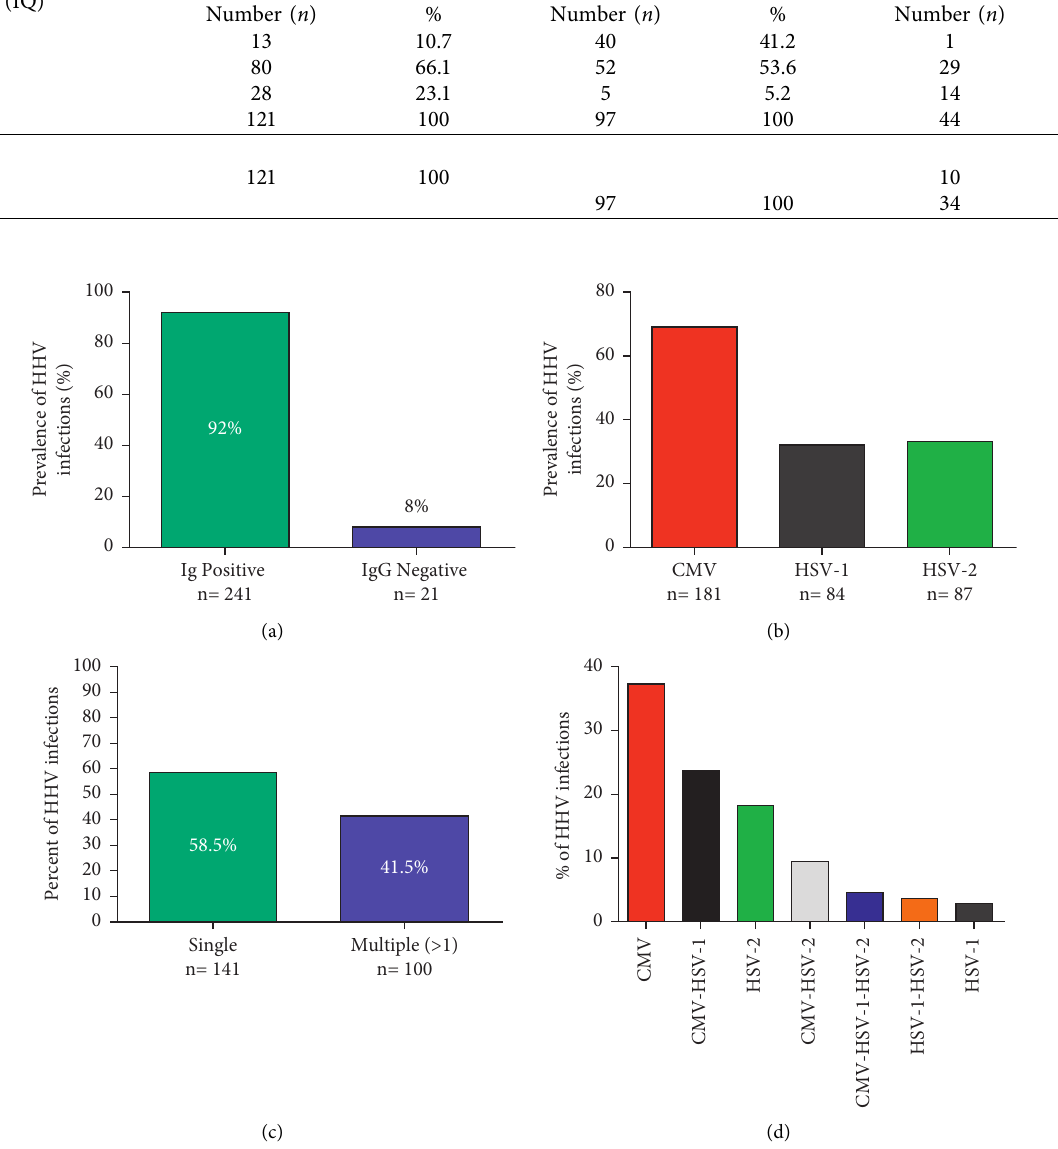
Figure 1: Seroprevalence of HHV coinfections among HIV-infected key population. (a) The overall seroprevalence of human herpesvirus (CMV, HSV-1, and HSV-2) infections ( n � 262). (b) The overall prevalence of each of the HHV infections. (c) The proportion of single HHV infection and multiple infections ( > more than 1 HHV infection) among key populations tested positive for IgG (CMV, HSV-1, and HSV-2). (d) The distribution (frequency) of HHV single and multiple coinfections in HIV-1-infected key